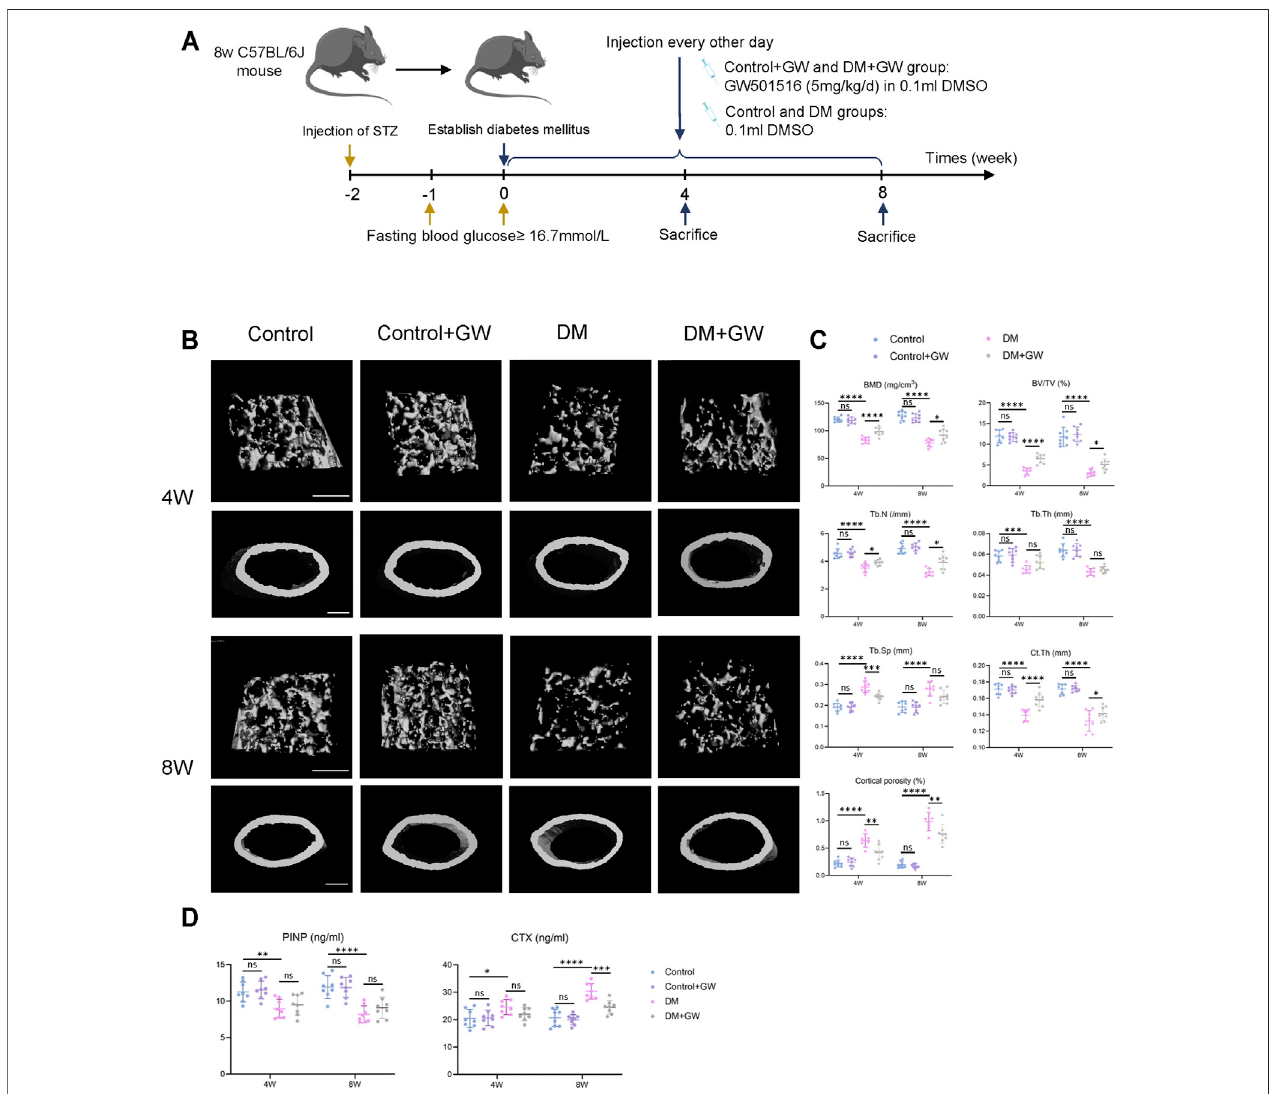
FIGURE 1 | PPAR β / δ agonist alleviates the osteoporosis phenotype in diabetic mice. (A) Schematic illustration of experimental design for PPAR β / δ agonist treatment. (B) Representative images of μ CT of distal femoral tissue at the 4 th and 8 th week. Scale bar (cid:2) 500 µm. (C) Quantitative μ CT analyses of bone mineral density (BMD), bone volume/total volume (BV/TV), trabecular number (Tb.N), trabecular separation (Tb.Sp), trabecular thickness (Tb.Th), cortical bone thickness (Ct.Th), and cortical bone porosity (Ct.Po) of distal femoral tissue ( n (cid:2) 8). (D) Serum levels of PINP and CTX in each group. Data were expressed as mean ± SD. The p values were calculated by two-way ANOVA. (ns, not statistically signi fi cant, * p < 0.05, ** p < 0.01, *** p < 0.001, **** p < 0.0001).